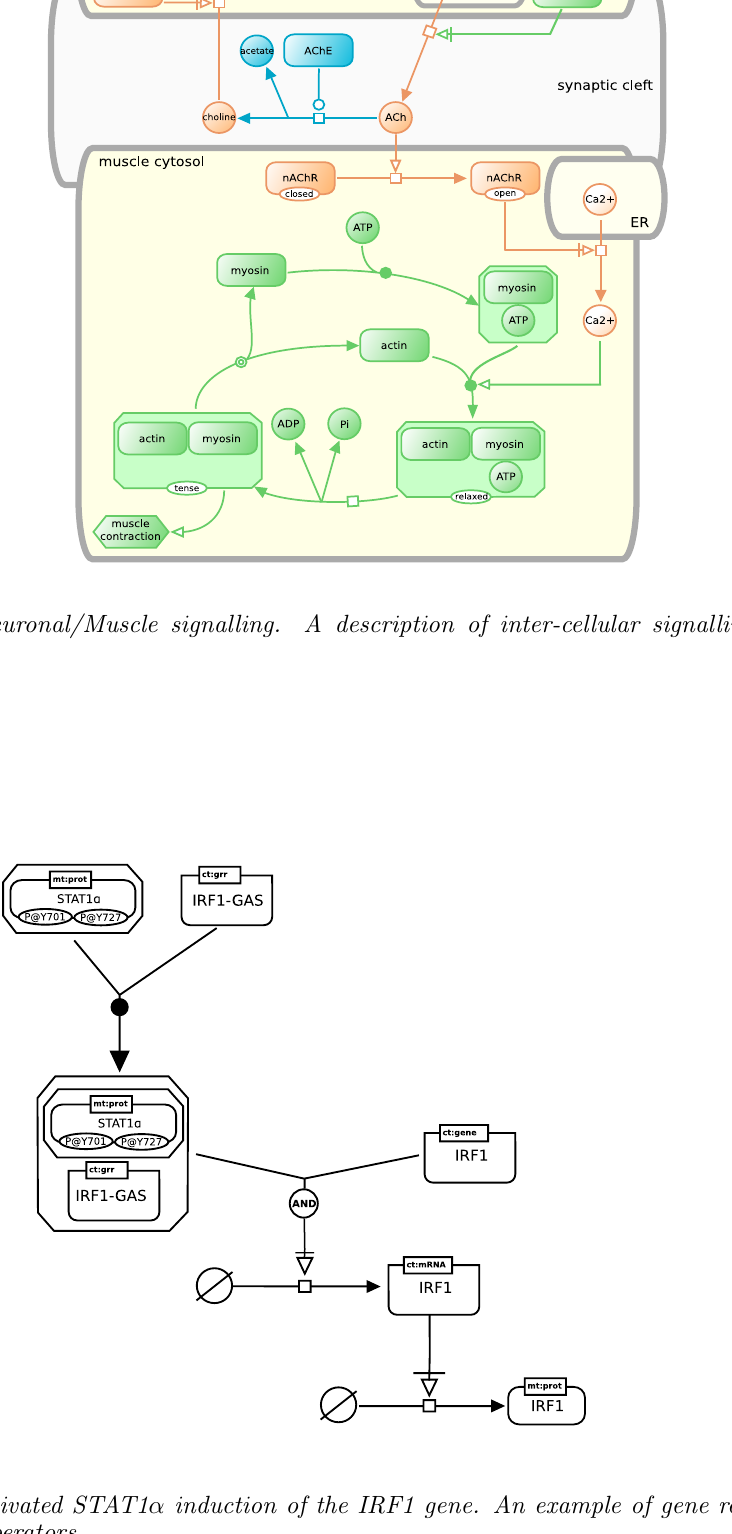
Figure A.5: Activated STAT1 α induction of the IRF1 gene. An example of gene regulation using logical